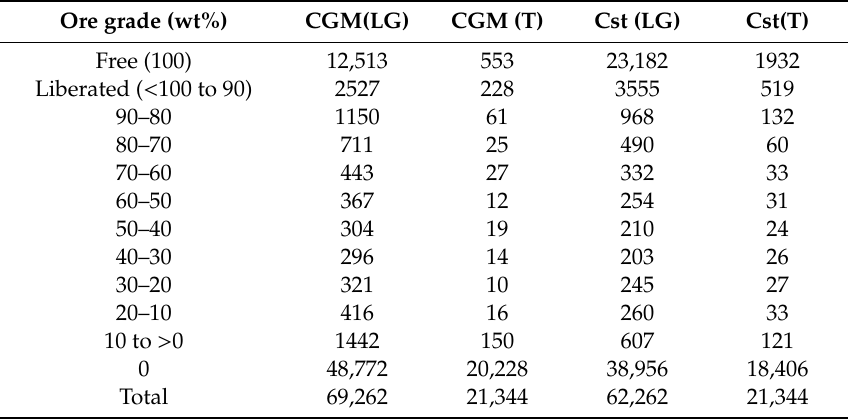
Table 5. Number of particles measured in the MLA according to the ore grade.